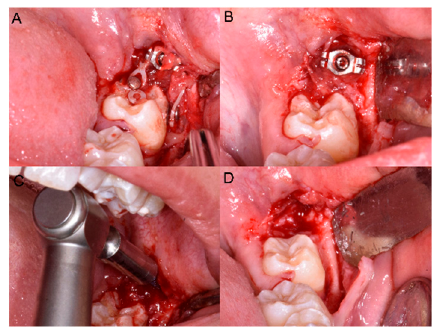
Figure 4. ( A , B ) The elastic chain, brackets and ( C ) the miniscrew removal. ( D ) The final position in the arch of 3.7.